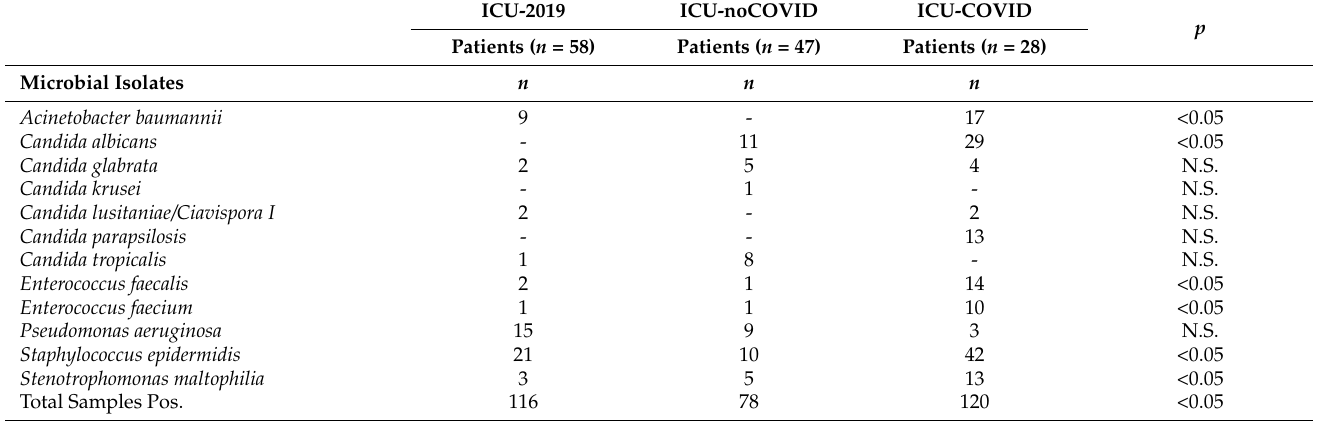
Table 3. Bacterial and fungal isolates in patients admitted in three ICUs.